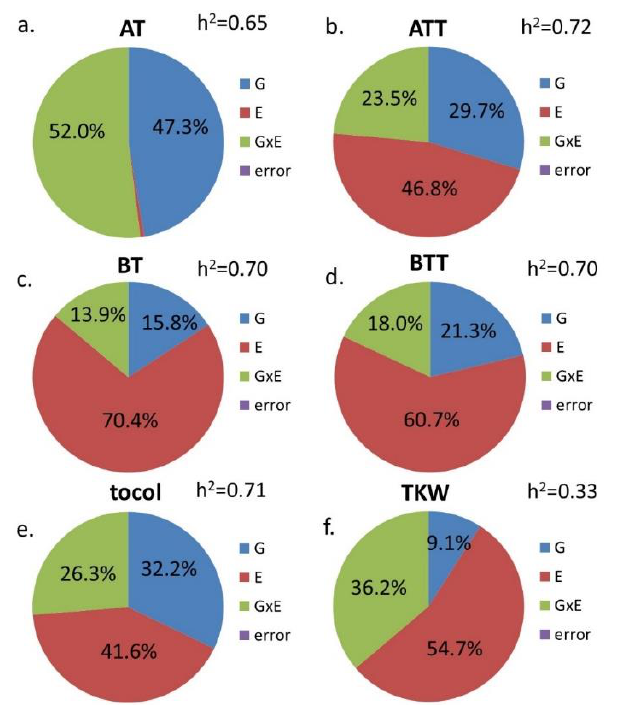
Figure 2. Pie diagrams of the relative contribution of genotype (G), environment (E, 2 years), and genotype × environment interaction (G × E) to the total sum of squares for the tocol content and composition of bread wheat, where ( a ) AT = α -tocopherol, ( b ) ATT = α -tocotrienol, ( c ) BT = β -tocopherol, ( d ) BTT = β -tocotrienol, ( e ) tocol = total tocol content, and ( f ) TKW = thousand-kernel weight (Martonvásár, 2014 and 2019, n = 230).